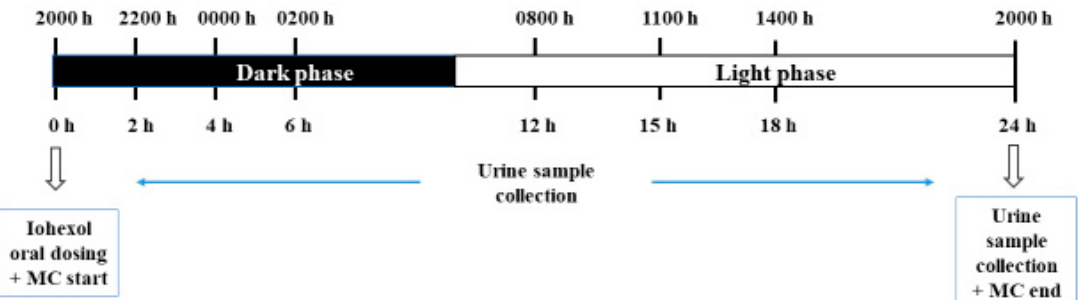
Figure 2. Timeline for the metabolic cage housing and urine sampling. MC, metabolic cage.